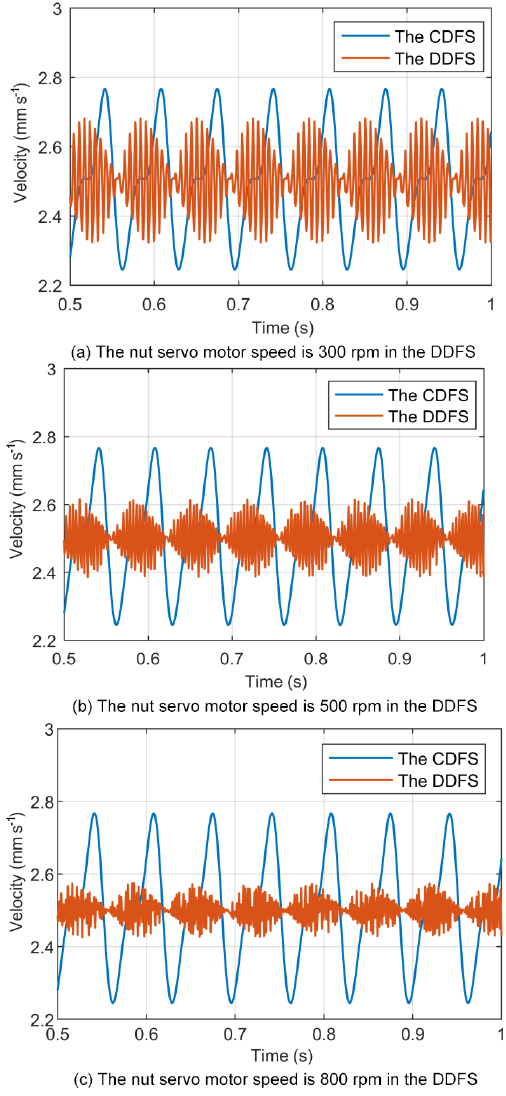
Figure 4. Comparison of the table velocity fluctuations of CDFS and DDFS at 2.5mms − 1 under 1Nm load torque.